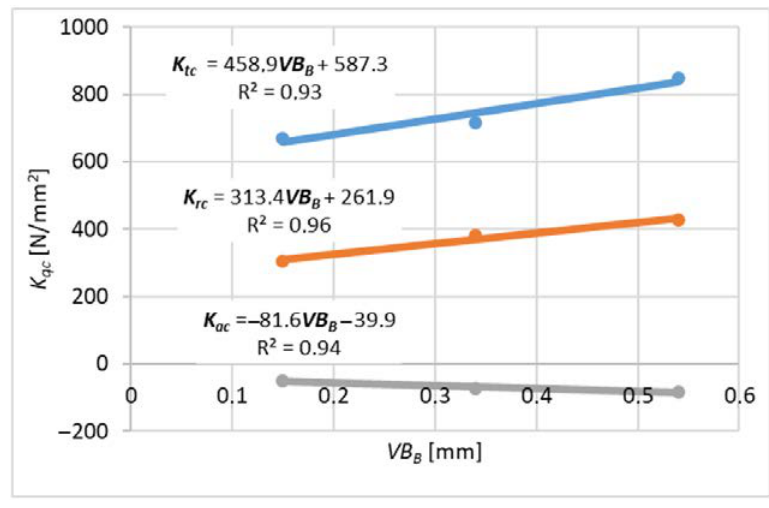
Figure 11. Effect of tool wear on the cutting force coefficient K c for slot-milling.